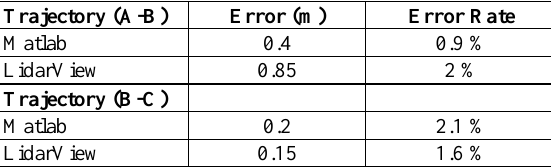
Table 2 . Error values for both trajectories